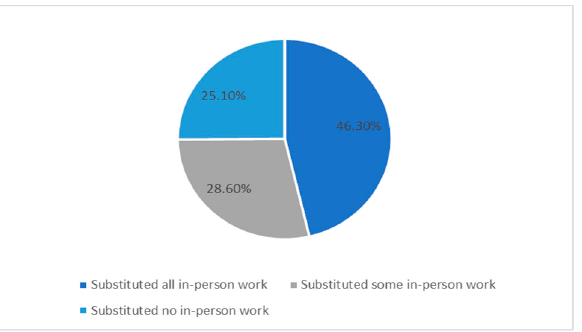
Figure 1. Transition to telecommuting among the participating households.